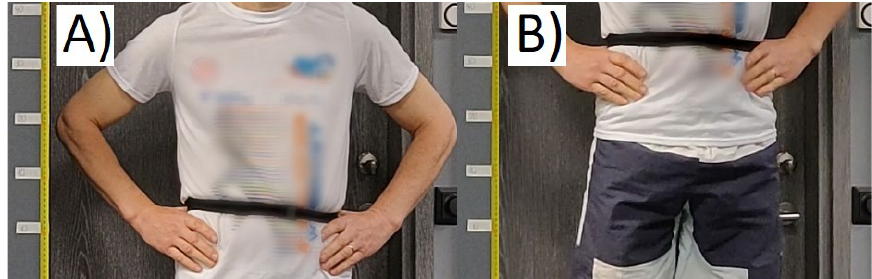
Figure 2. Countermovement jump (CMJ) height measurements. The subject is ( A ) standing and ( B ) at the maximum height. CMJ height was found as the vertical difference of the belt, which was firmly attached around the torso.